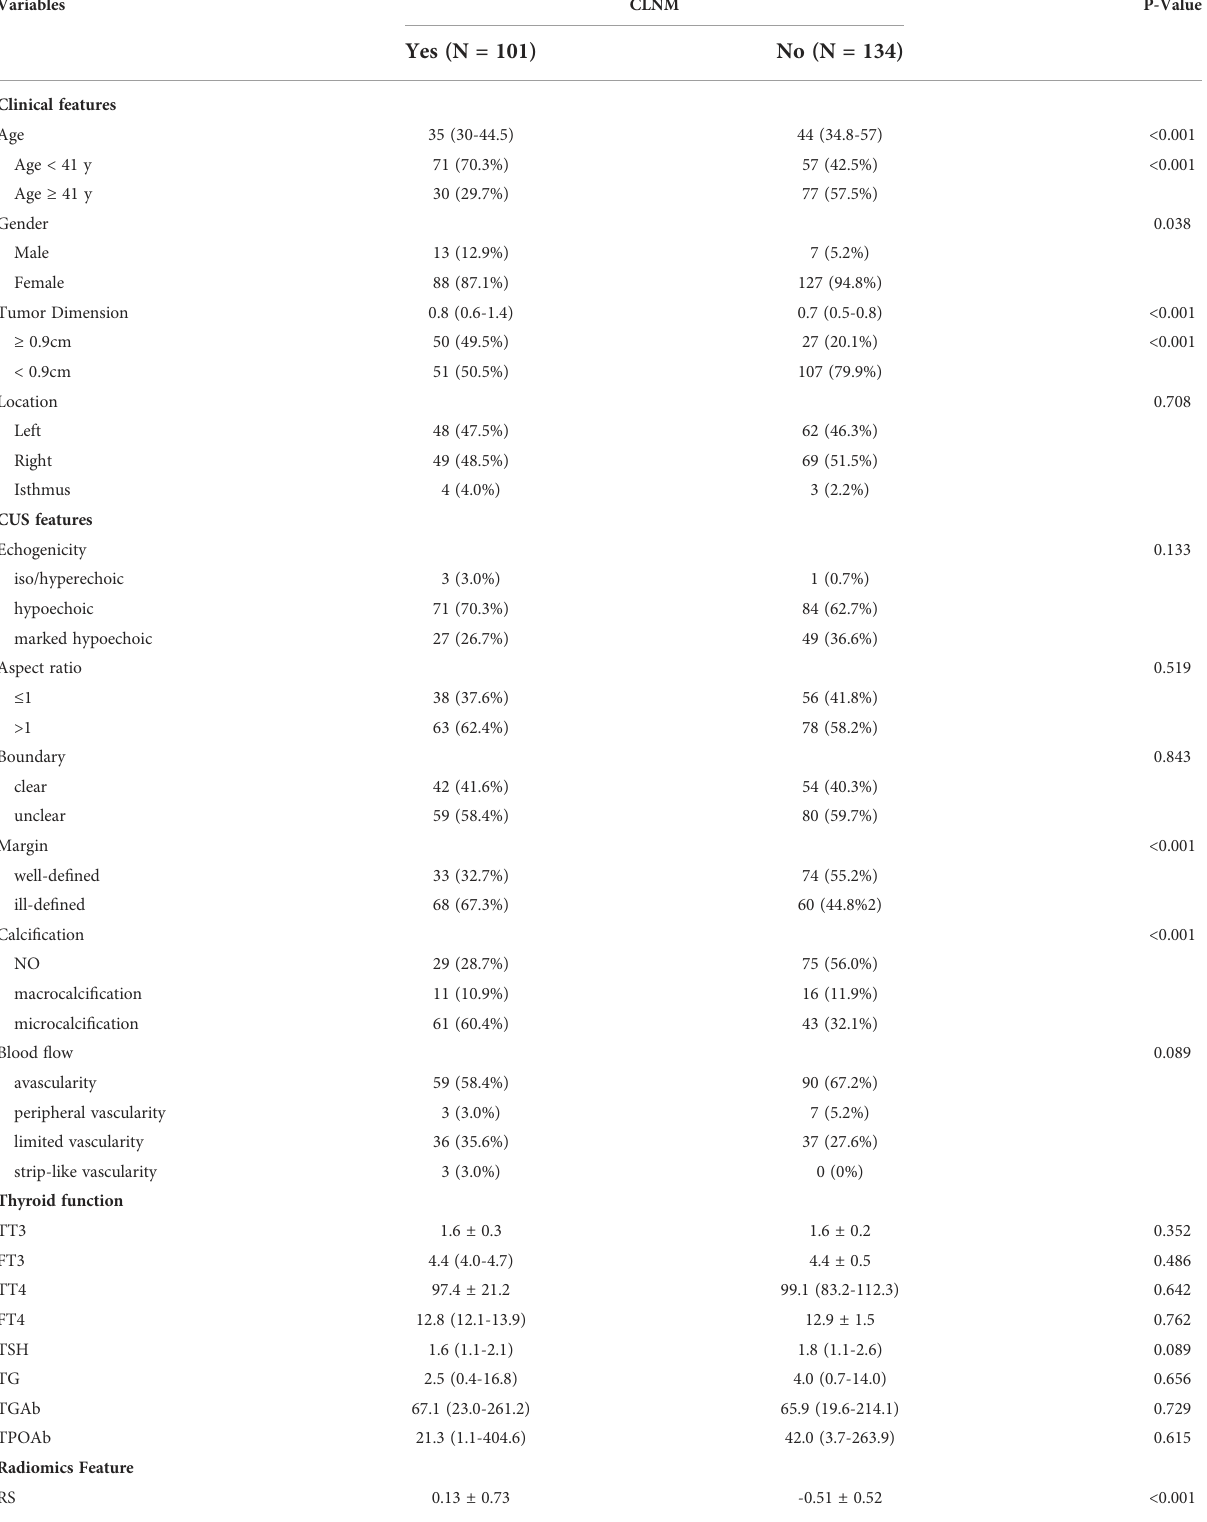
TABLE 1 Baseline clinical data of all PTC patients with